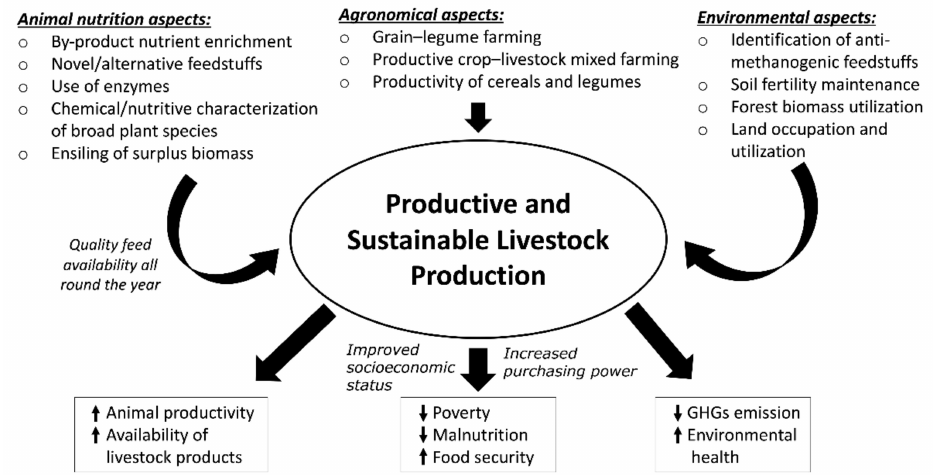
Figure 4. Future considerations to establish a productive and sustainable livestock production system in Nepal. Issues associated with animal nutrition, agronomy, and the environment are important to develop a productive livestock sector in Nepal, which could fulfill increasing demands for livestock production in changing demographic and socio-economic situations. (arrow; ↑ : improvement, arrow; ↓ : reduction); GHGs, greenhouse